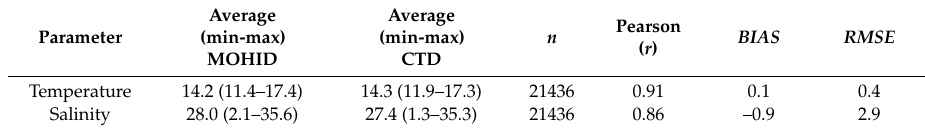
Table 3. Surface seawater temperature and salinity. Data summary and results of statistics used to assess the level of agreement between measured data and modelling results. n —number of